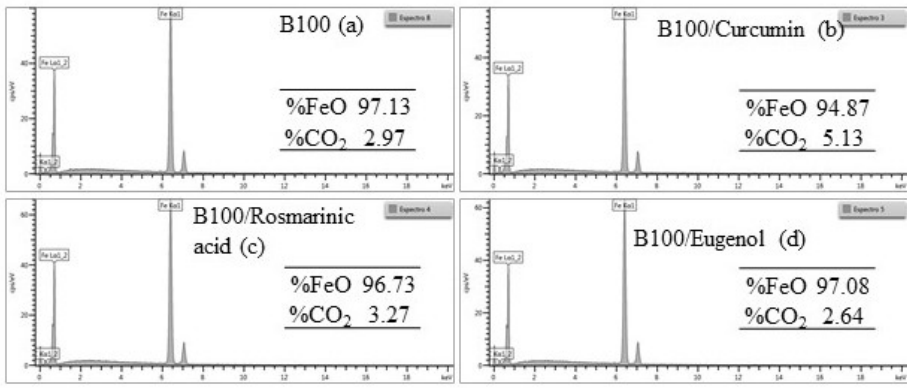
Figure 7. EDS analysis results of the carbon steel surface before and after immersion in B100 in the absence and presence of different additives.